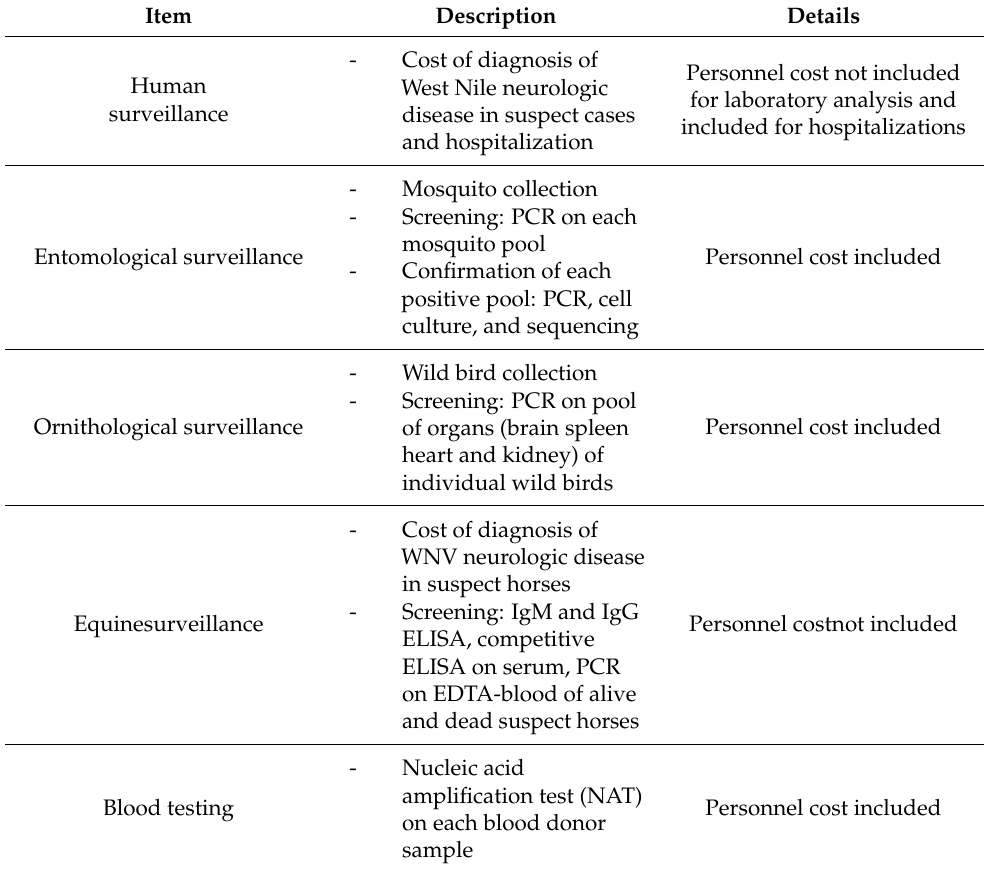
Table 1. Cost items included for the estimation of costs of the West Nile Virus (WNV) integrated surveillance system in Lombardy, 2014–2018. Item Description Details Cost of diagnosis of Personnel cost not included Human West Nile neurologic for laboratory analysis and surveillance disease in suspect cases included for hospitalizations and hospitalization